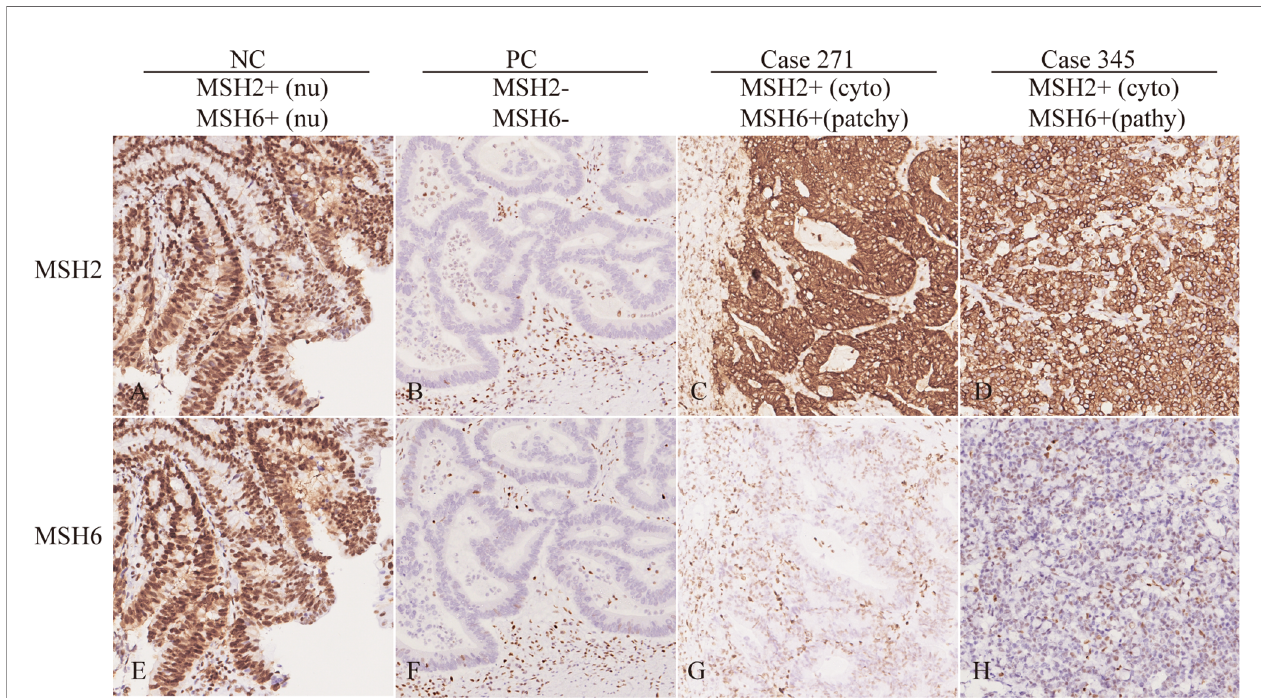
FIGURE 1 | Rare MSH2 cytoplasmic staining in CRC. IHC of MSH2 and MSH6 in selected patients showing protein expression in tumor cells. The NC (negative control with pro fi cient MMR) showed nuclear staining of MSH2 and MSH6. The PC (positive control with de fi cient MMR) showed loss of nuclear staining of MSH2 and MSH6. However, patient 271 and 345 showed cytoplasmic MSH2 and patchy/weak MSH6 nuclear staining in tumor cells. Nu, nuclear; cyto,